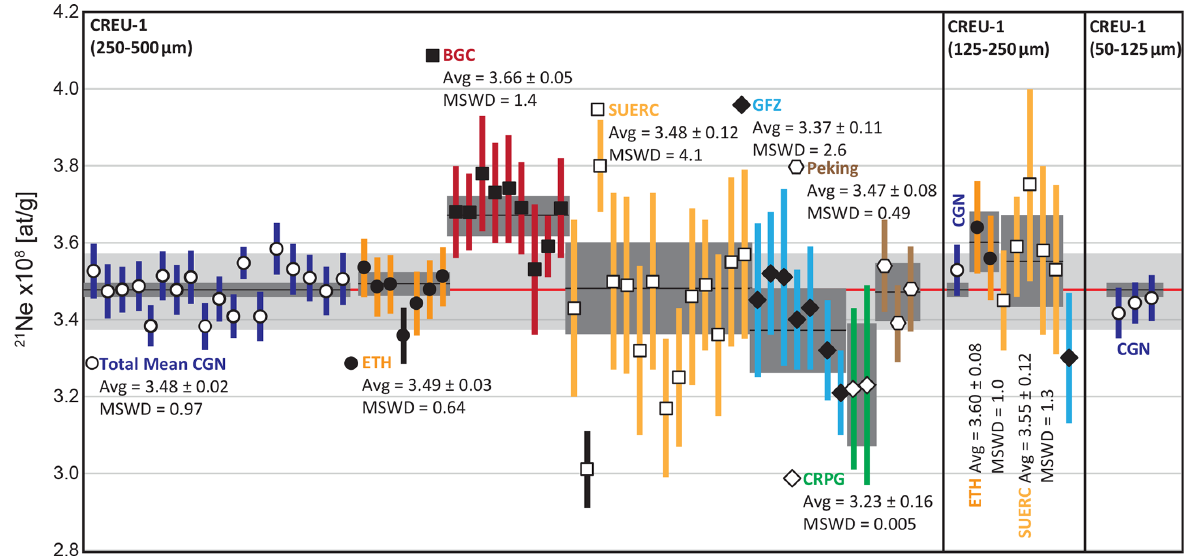
Figure 6. Compilation of CREU-1 21 Ne concentrations ( ± 2 σ uncertainties) measured at Cologne (CGN), compared to reported 21 Ne con- centrations from interlaboratory comparison from Vermeesch et al. (2015) and data from the Peking noble gas lab from Ma et al. (2015). Black bars were considered outliers by the original authors and not used for calculation of averages (Vermeesch et al., 2015). The data are divided into three sections, each for a different CREU-1 grain size analysed. The average 21 Ne concentration for CREU-1 of 3.48 ± 10 × 10 8 atomsg − 1 reported by Vermeesch et al. (2015) is marked as a light-grey band and a red line for the mean. Lab-individual error-weighted means are displayed as black lines with their respective uncertainty in dark grey. The average obtained for CREU-1 at Cologne (all grain sizes, n = 22) is 3.48 ± 0.02 × 10 8 atomsg − 1 ( ± 2 σ ; error-weighted standard deviation). The MSWD values (mean square of the weighted deviates (“reduced Chi-square”, Mcintyre et al., 1966)) are reported for all individual laboratory means (Vermeesch et al.,